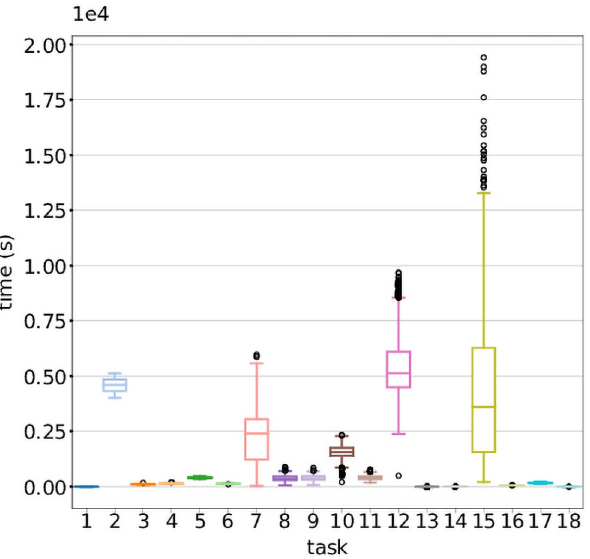
Fig 2. Runtime of workflow tasks across all problem sizes. Distribution of the runtimes of the 18 task types over all problem sizes and runs. Tasks 2, 7, 12 and 15 had the highest runtimes overall, as well as the largest degree of variability. Fig 4 shows the median runtime of the tasks for each problem size, averaged over the 5 runs, stacked and color-coded by task type. Again, it is visible that tasks 2, 7, 12 and 15 contribute substantially to overall workflow runtime. The median task runtime remains constant for all tasks except 15, where it grows with problem size.